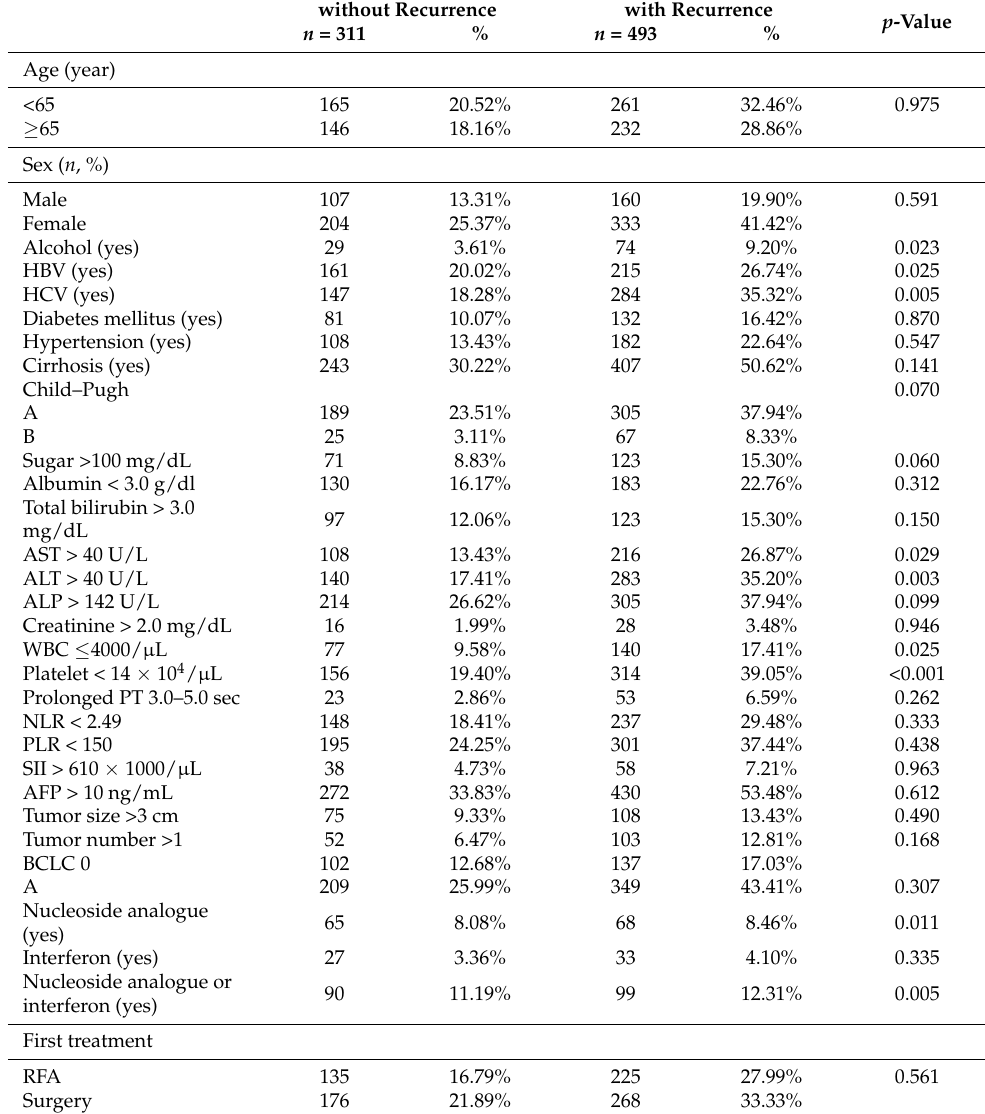
Table 1. Baseline clinical characteristics of patients with and without post-curative hepatocellular carcinoma (HCC) recurrence over five